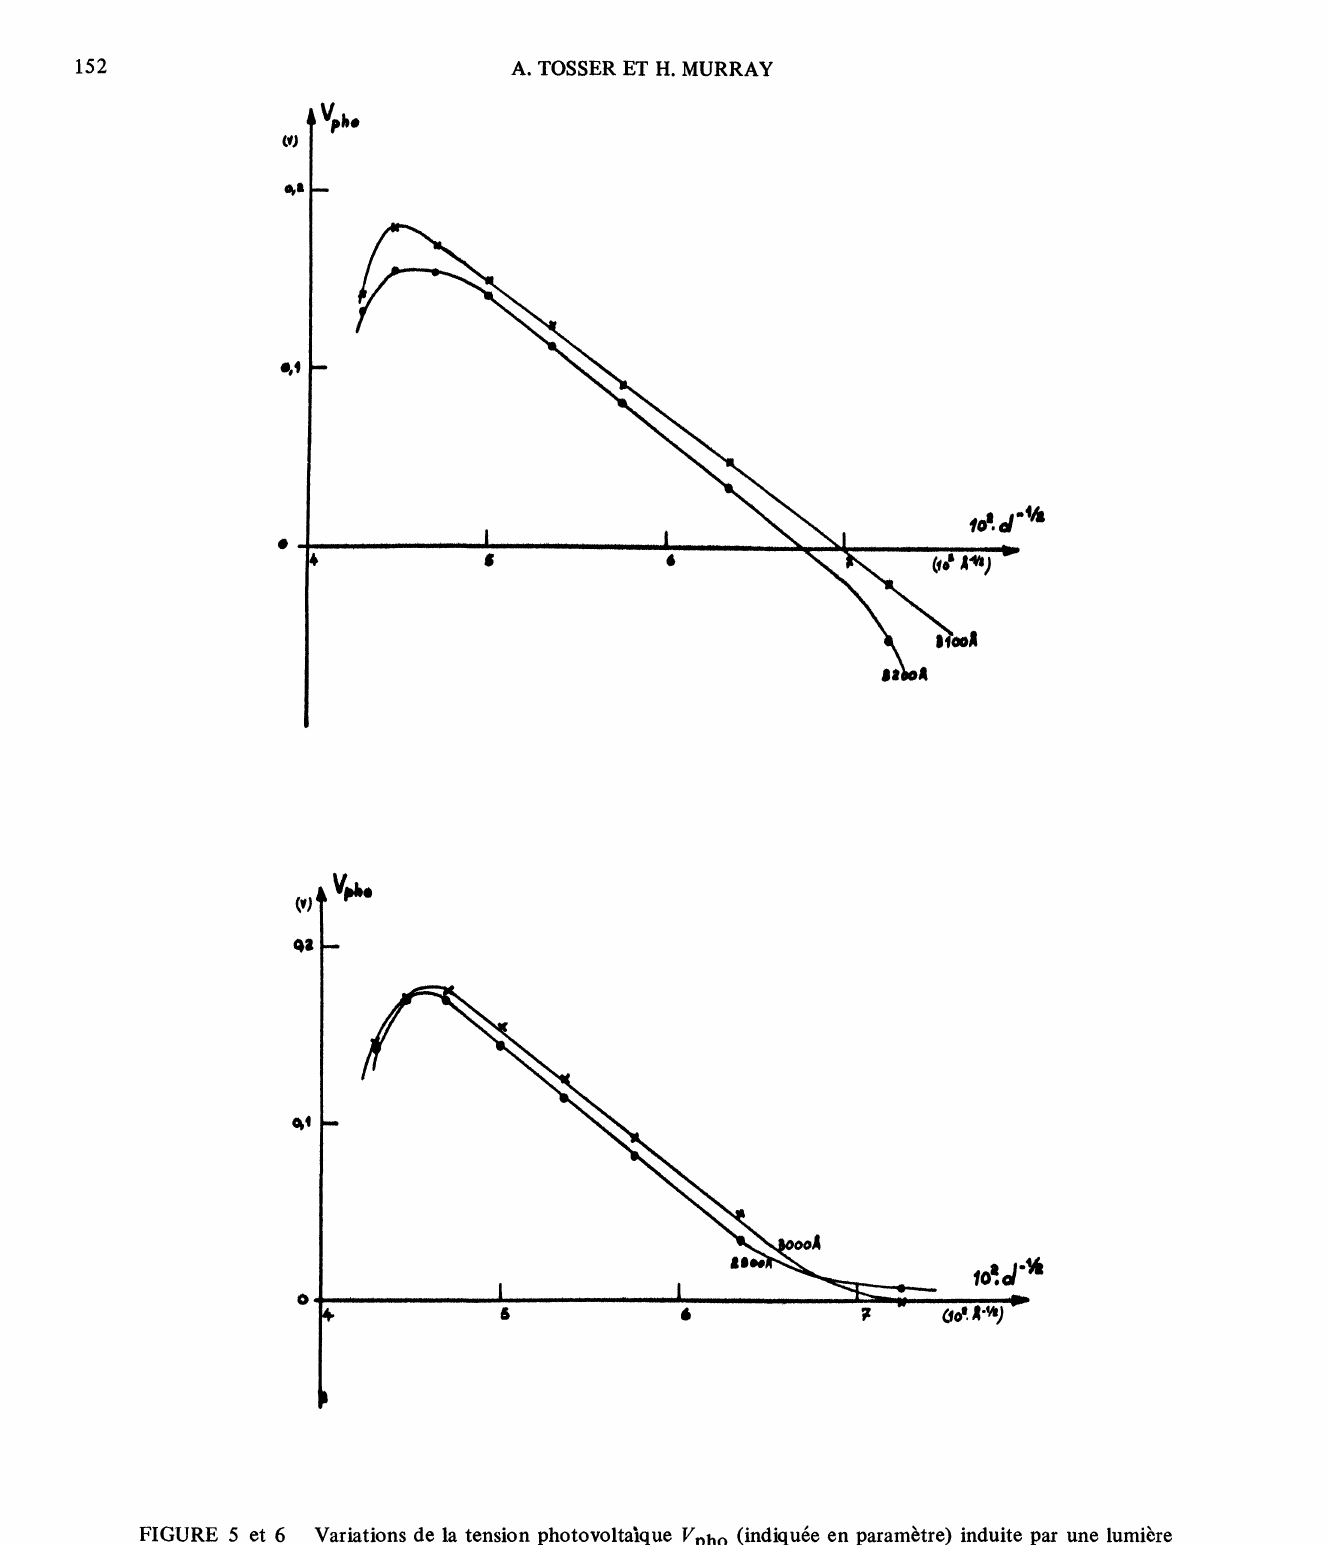
FIGURE 5 et 6 Variations de la tension photovolta]que Vp,h,o (indiqu6e en paramtre) induite par une lumire de longueur d’onde variable dans une couche de sulfure de zinc d paisseur d en fonction de 10 od-ll